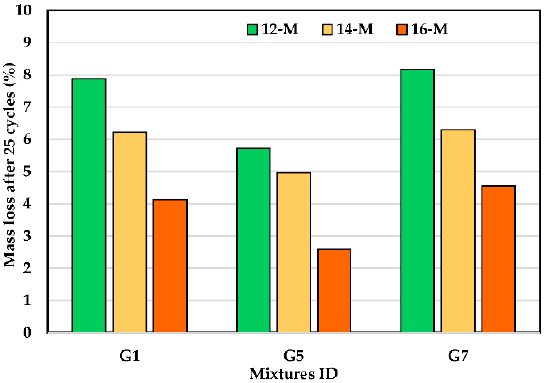
Figure 12. Effect of KOH molarity on freeze–thaw cyclic of the UHPGC at curing heat 60